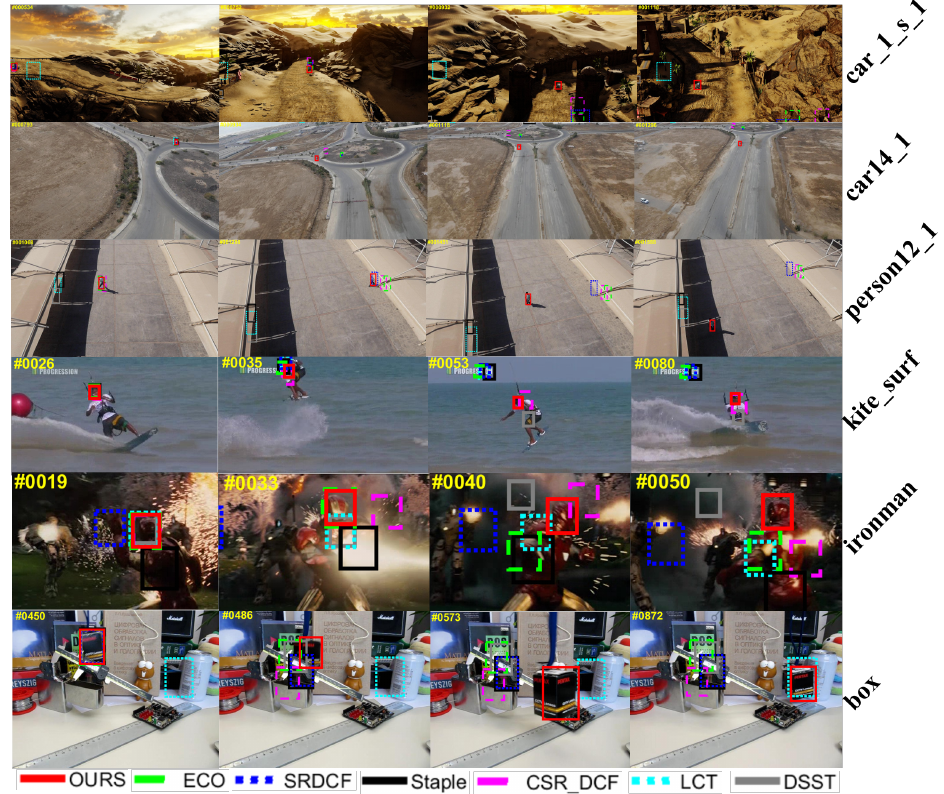
Figure 12. Qualitative comparison of the trackers on several